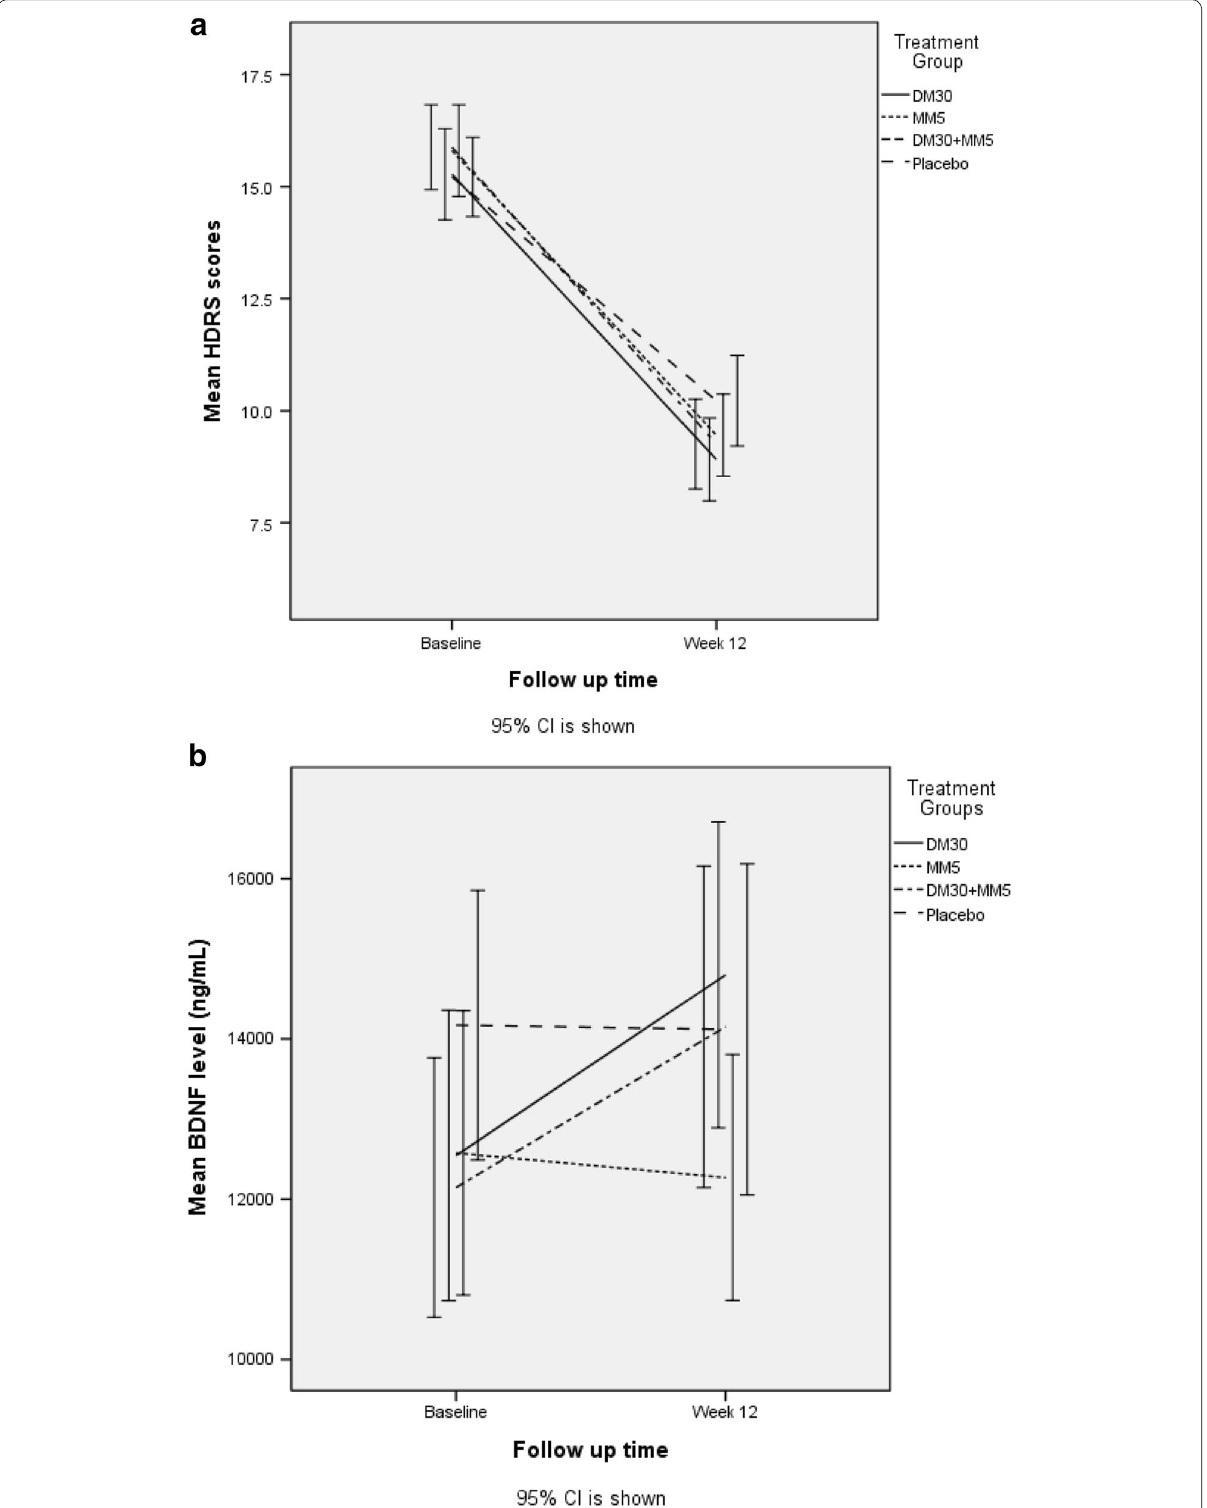
Fig. 2 a Difference in symptoms of depression in BD‑II patients taking add‑on DM30, MM5, and DM30 plasma BDNF levels in BD‑II patients taking add‑on DM30, MM5, and DM30